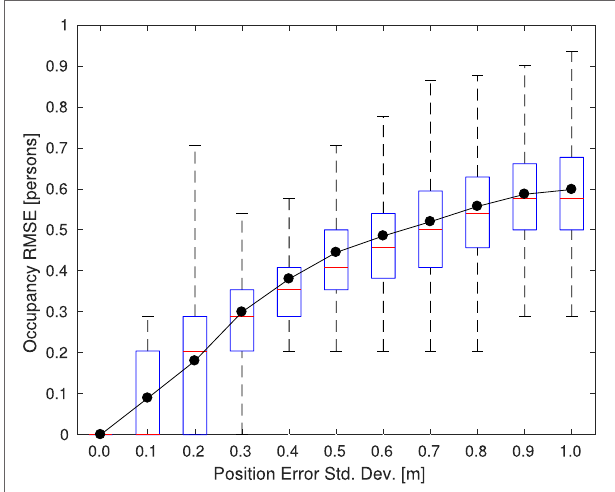
FIGURE 10 | The occupancy count RMSE using true footstep assignment in the crossing scenario.